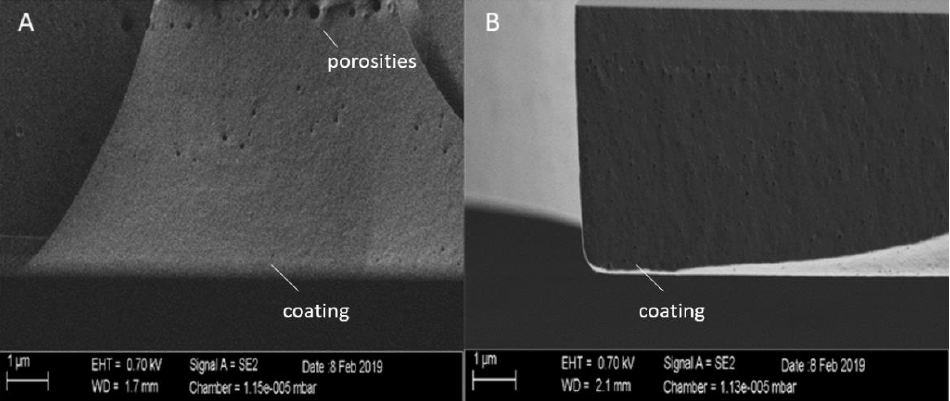
Figure 2. Scanning electron microscope (SEM) images of the layers without ( A ) and with Cu ( B